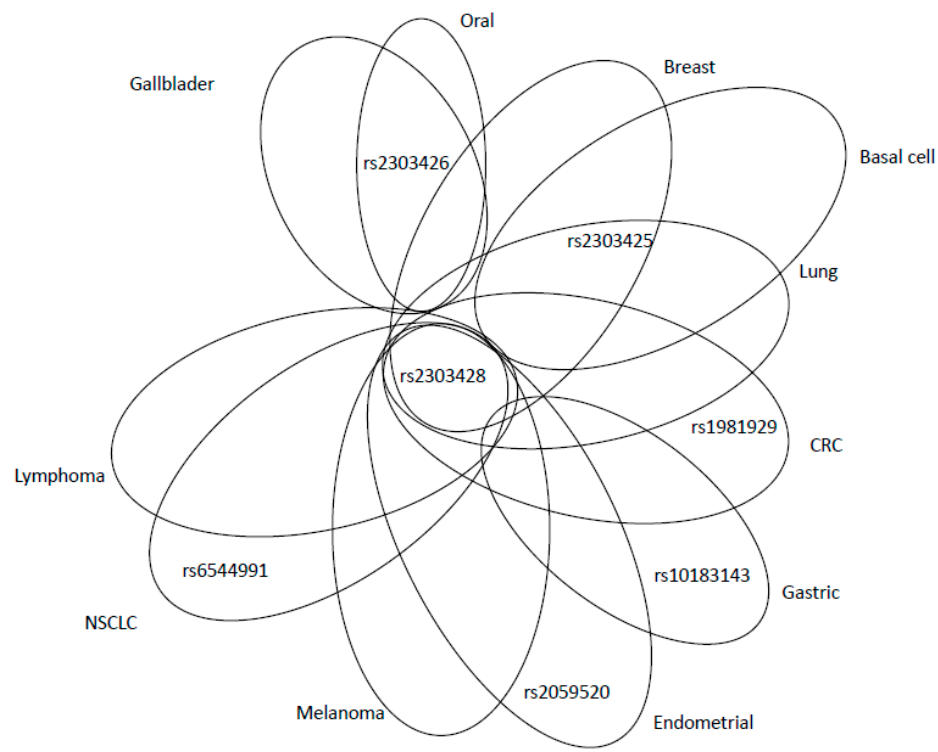
Figure 5. Venn diagram showing relevant MSH2 SNPs associated with adverse effects, in overlap among different cancer types or peculiar for specific malignancies. CRC: colorectal cancer; NSCLC: non-small-cell lung cancer.